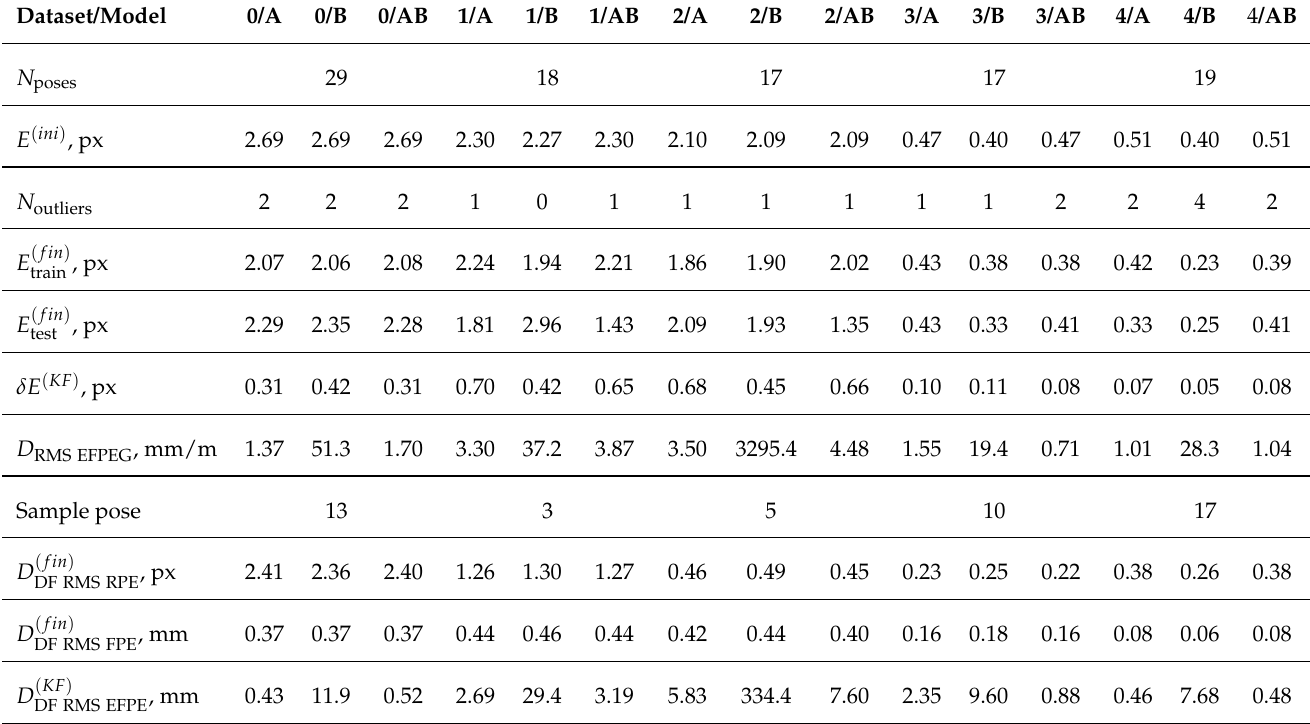
Table 1. Outcomes of our experiments. The meaning of entries is described in the